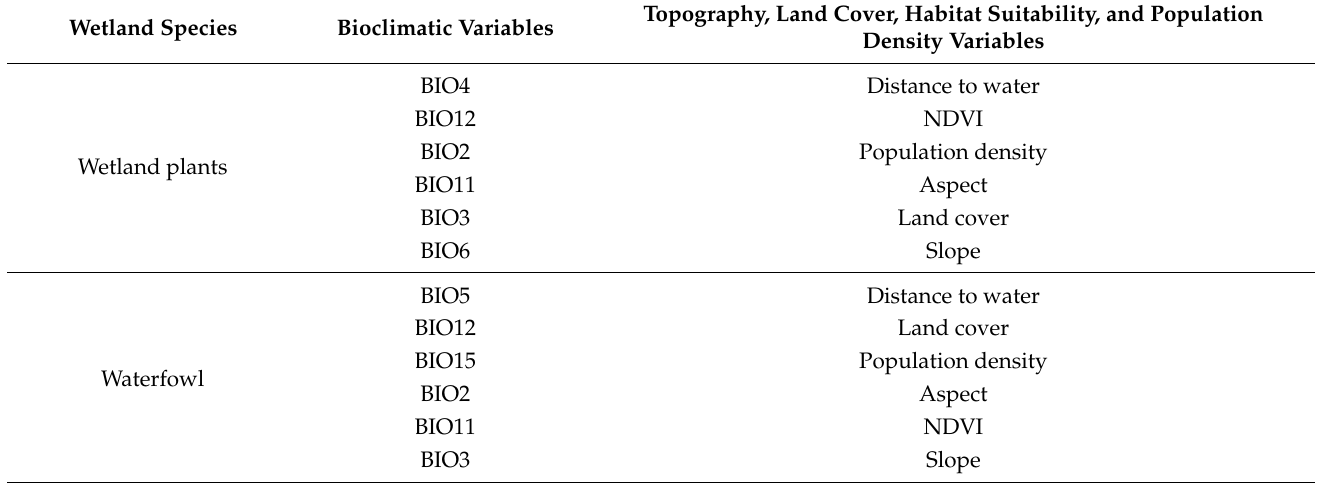
Figure 2. Groups of intercorrelated variables at a cut-off of 0.7. Table 2. Screening of the environmental factors that contribute most to the model and are not rele- vant.